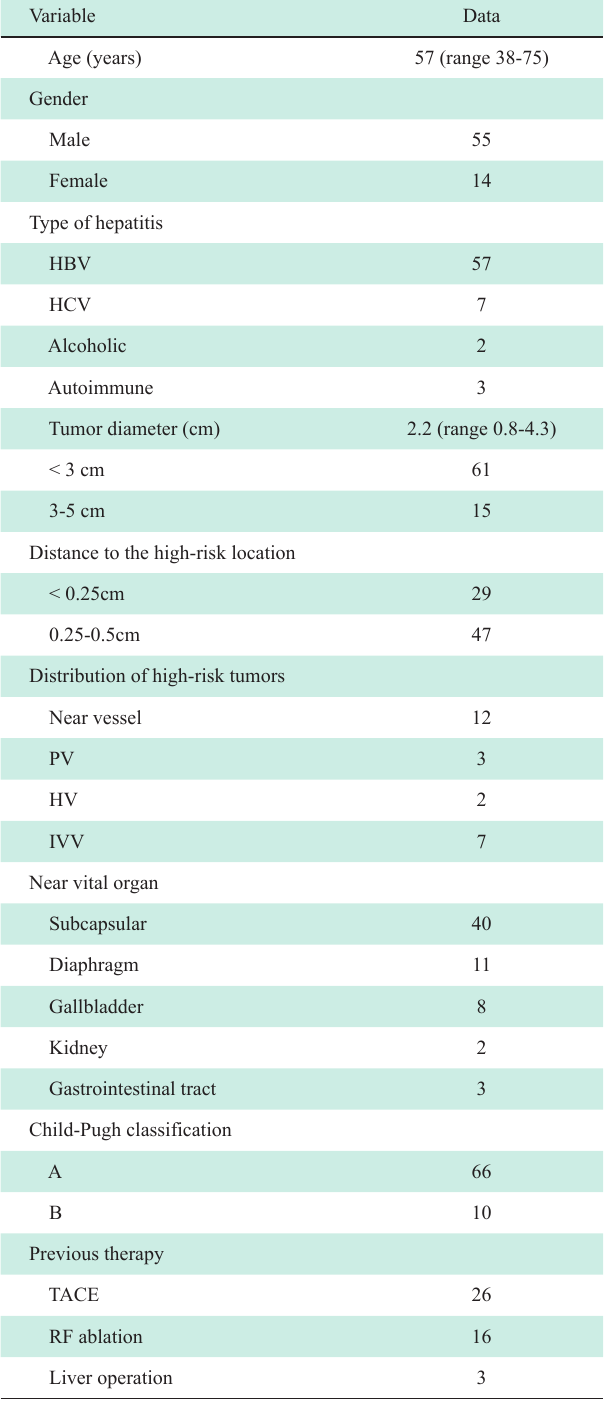
Table 1 Patient population and tumor